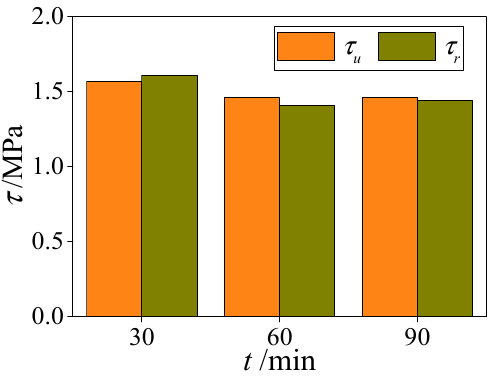
Figure 16. The effect of concrete strength on bond strength ( a ) ultimate bond strength; ( b ) residual bond strength.